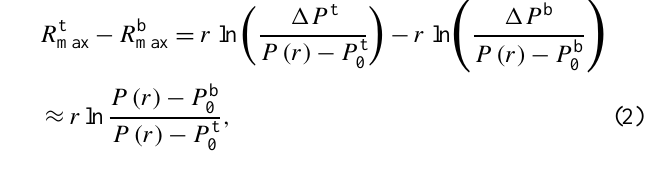
Table 1. Major tropical cyclones in the last 10 years causing exten- sive storm